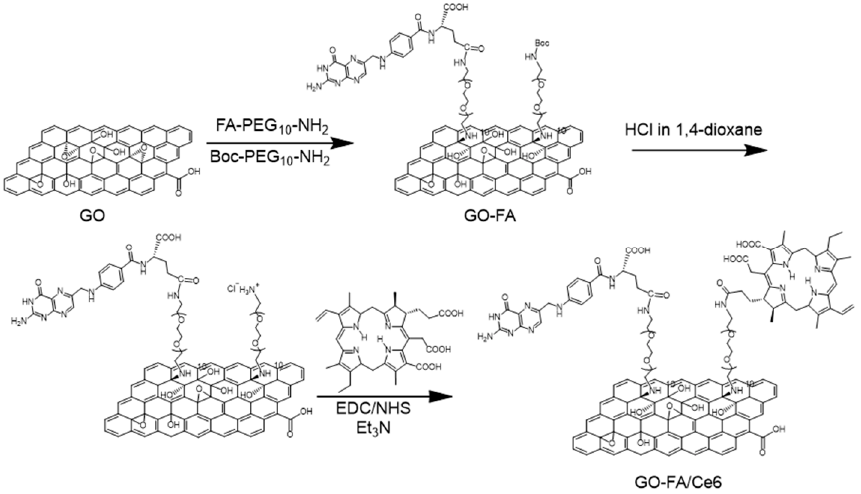
Scheme 1. Synthesis of GO–FA/Ce6 conjugate (the three carboxyl groups of Ce6 can participate in the amidation reaction, but for clarity, we illustrated the modification of only one of them).